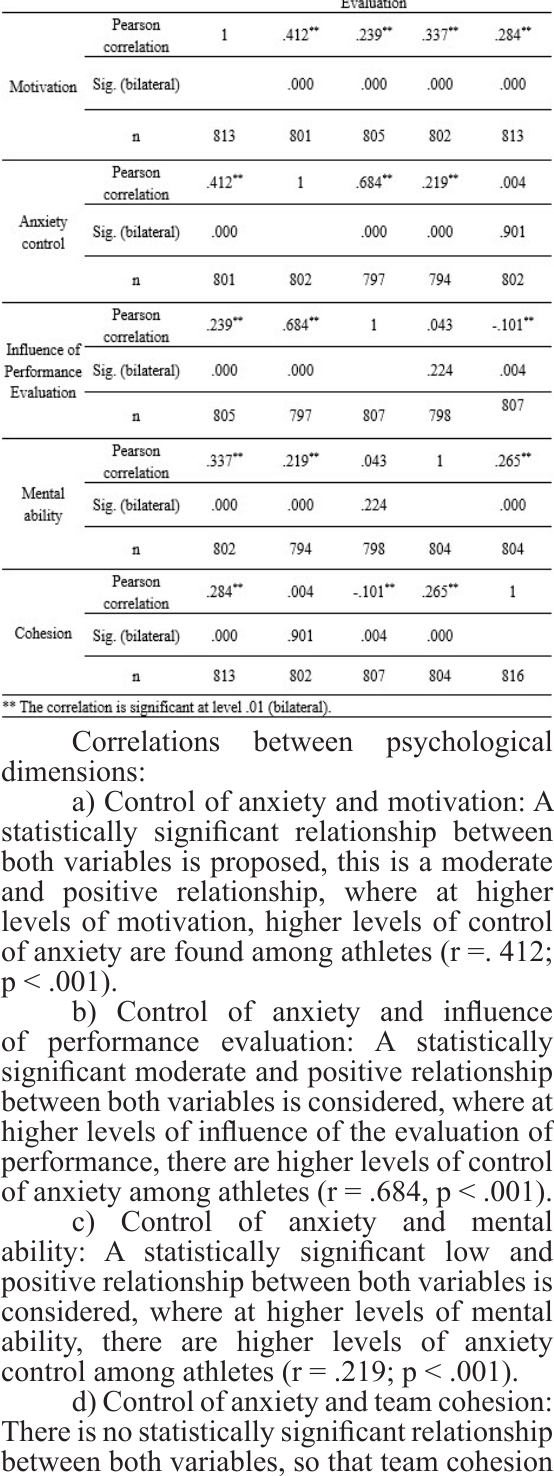
Table 5. Control of anxiety in relation to sports discipline